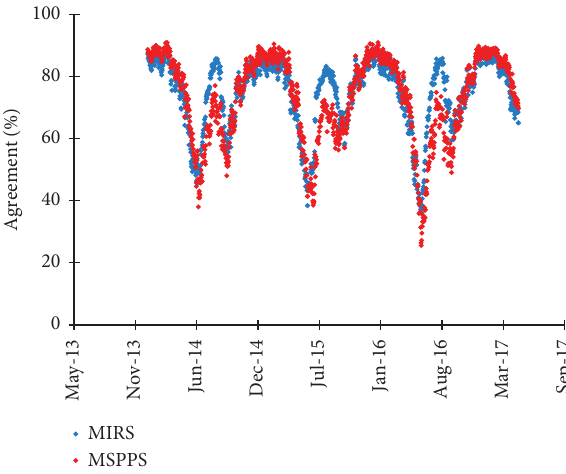
Figure 7: Daily rate of overall agreement for MIRS and MSPPS. Figure 8: Daily rate of snow sensitivity for MIRS and